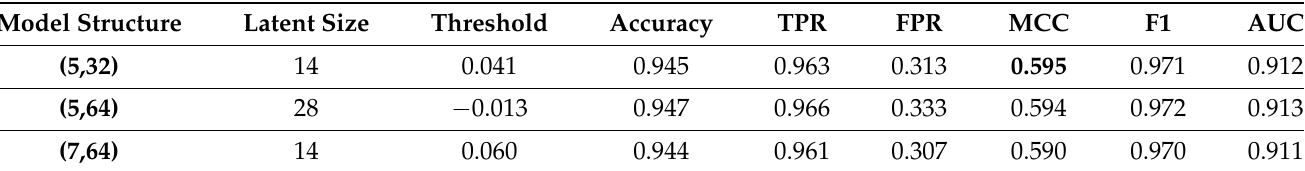
Table 8. Evaluation results with IoTID20 dataset. The best configuration from each model structure was chosen based on the MCC score. The reported metrics are averaged over 10 runs. The best MCC score is marked in bold. Model Structure